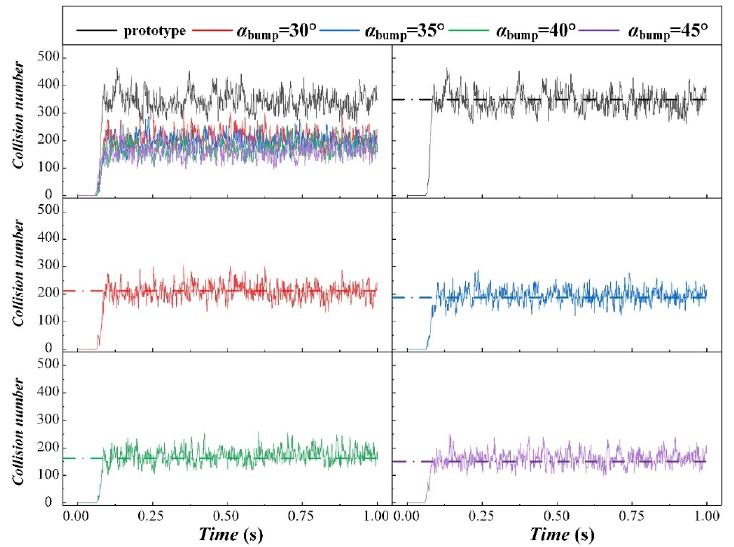
Figure 10. Schematic diagram of the number of particle collisions with the